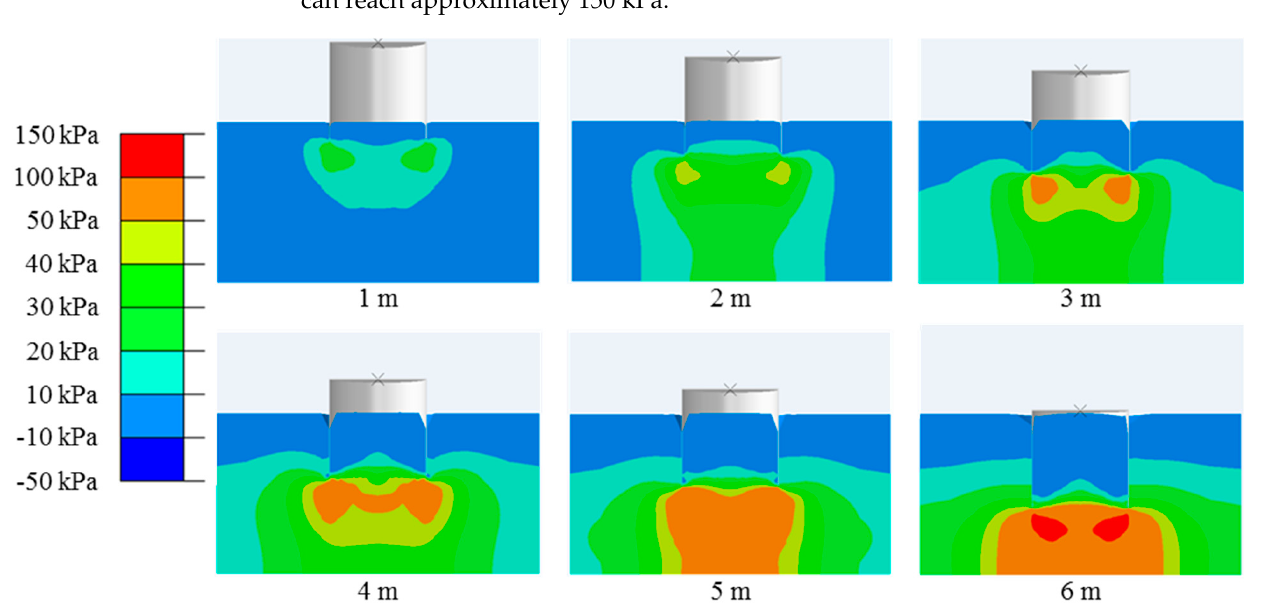
8 of 16 Figure 4. Jacked penetration resistance: ( a ) Numerical and centrifuge test results for penetration resistance; ( b ) Decompo- sition of penetration resistance from numerical results.